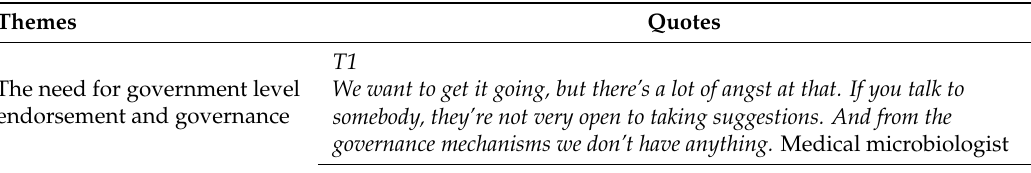
Table 3. The key emerging themes on education and training in antimicrobial resistance (AMR) and AMS from the semi-structured